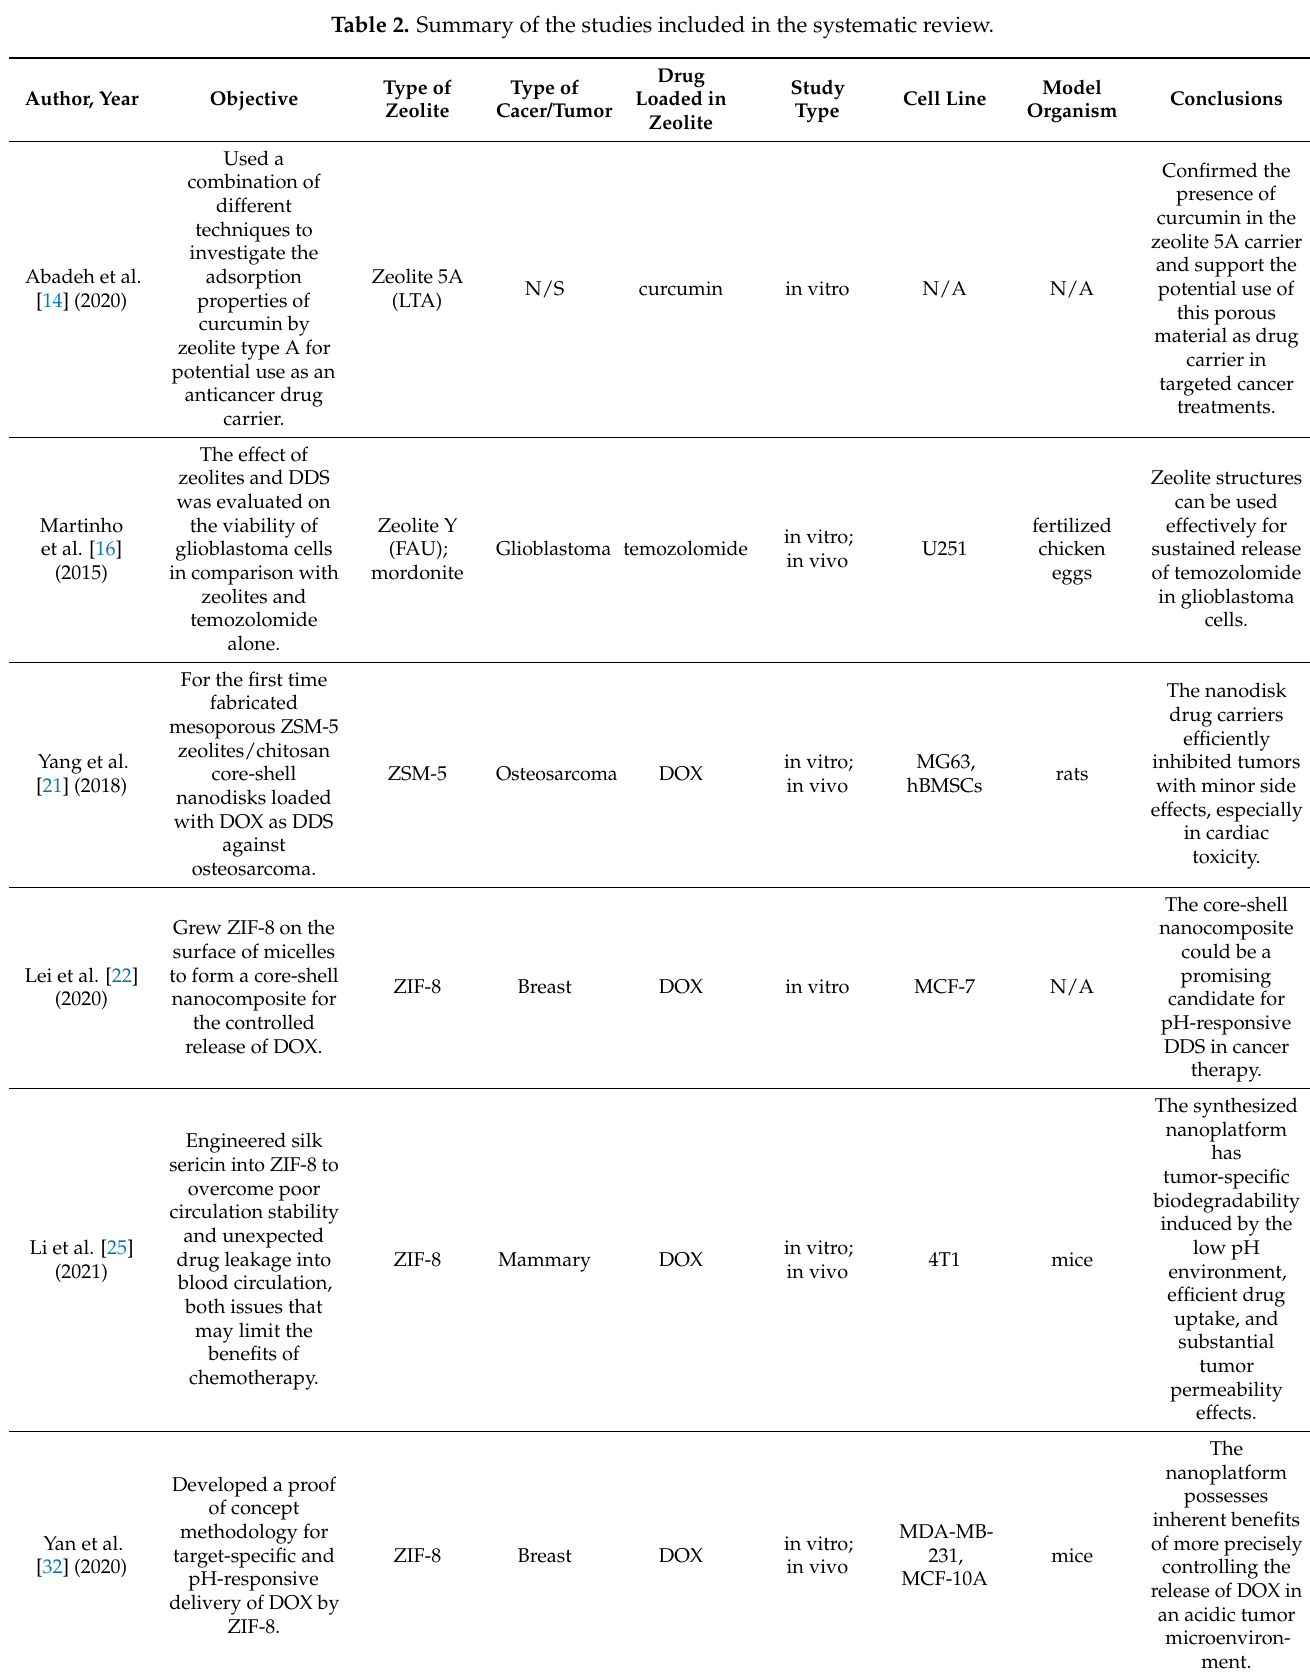
Table 2. Summary of the studies included in the systematic